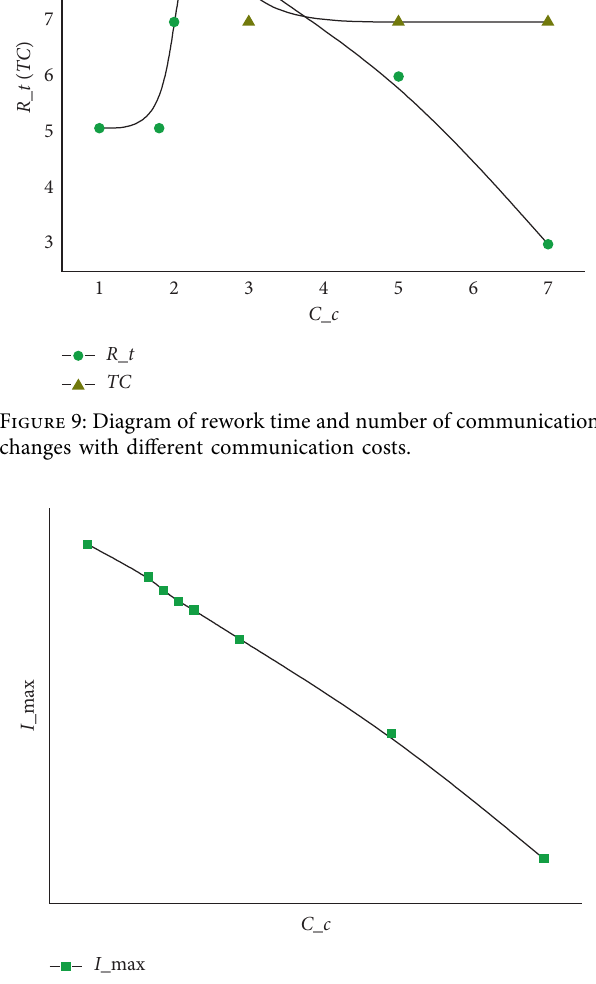
Figure 10: Diagram of communication cost-maximum